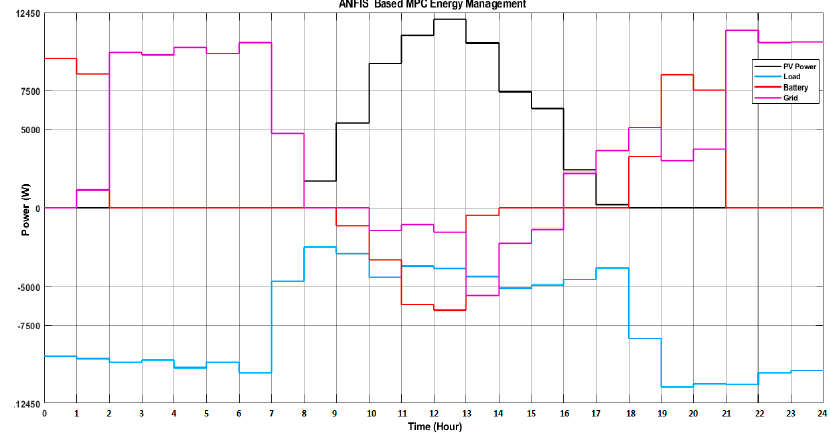
Figure 14. Power dispatching using energy management with rule-based controller (RBC) for 04/02/2019.